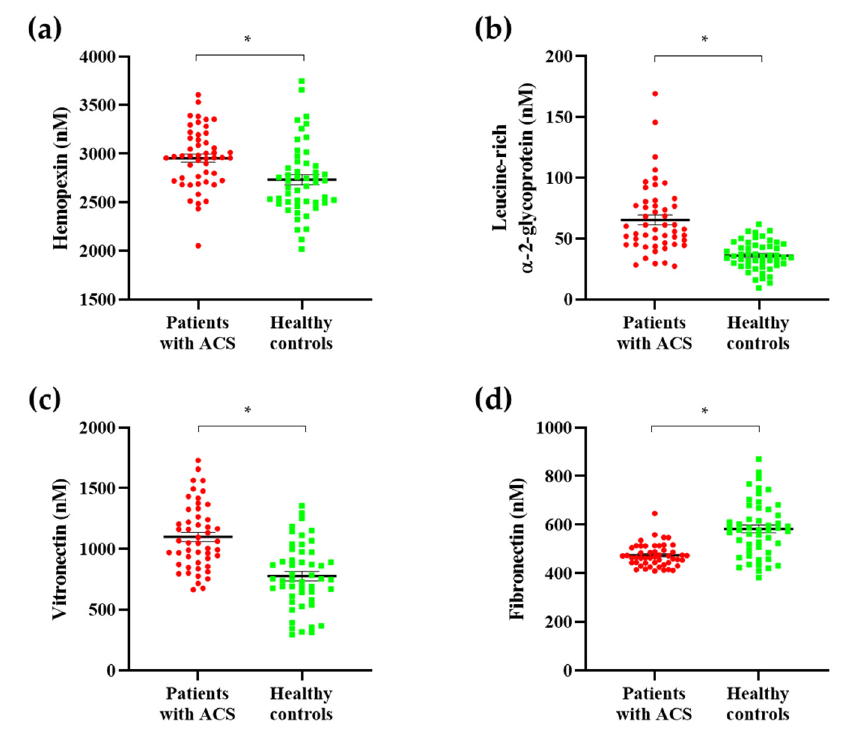
Figure 4. Scatter plots of ACS diagnostic biomarkers. To identify ACS diagnostic biomarkers, we developed a validation set. Among the protein candidates, ACS biomarkers were selected as proteins showing the same expression in the discovery set. Among the protein candidates, expression levels for ( a ) hemopexin, ( b ) leucine-rich α -2-glycoprotein, and ( c ) vitronectin were upregulated in patients with ACS. ( d ) Fibronectin expression was downregulated in patients with ACS. All ACS diagnostic biomarkers showed statistically significant results. * p < 0.001.